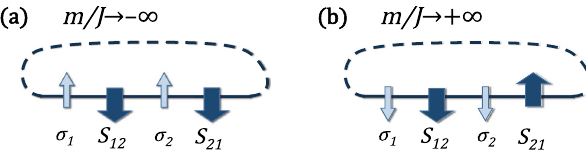
FIG. 9. Product states at m=J ¼ (cid:8)1 for the minimal imple- mentation of four ions. (a) State at m=J ! (cid:1)1 , conserving C and P invariance. (b) State at m=J ! þ1 , breaking C and P invariance. This state is degenerate with the opposite configura-